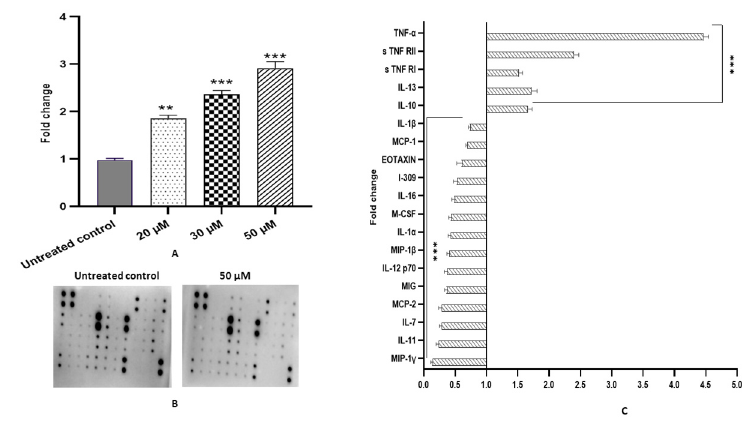
Figure 5. Analysis of inflammatory cytokines ( A ) Nitrocellulose membrane showing the differential expression of inflammatory cytokines ( B ) Graph showing the downregulation of pro-inflammatory and chemokines while showing upregulation in anti-inflammatory cytokines expression in fisetin treated (50 µM) compared with the DMSO control sample. ( C ) Graph showing an increase in total GSH level in fisetin-treated HeLa cells at 20, 30 and 50 µM for 48 h. Data are presented as the mean ± standard deviation of three independent experiments. Two-way ANOVA. ** = p < 0.01, *** p < 0.001.